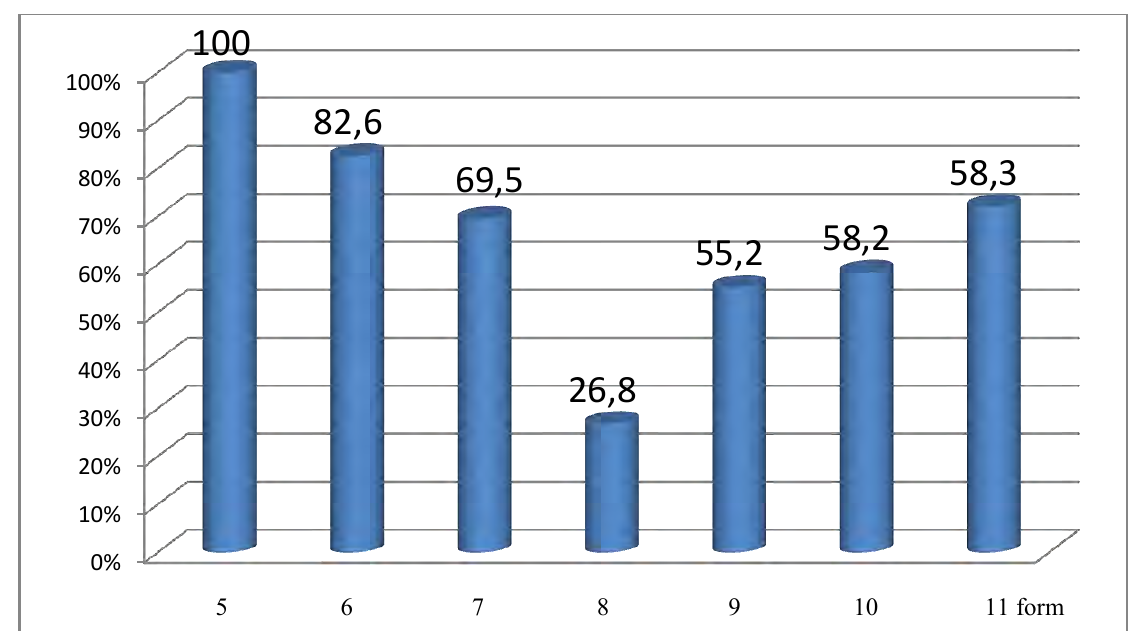
Fig.1. Indicators of 5-11 forms pupils’ activity in systemic physical culture-sports trainings